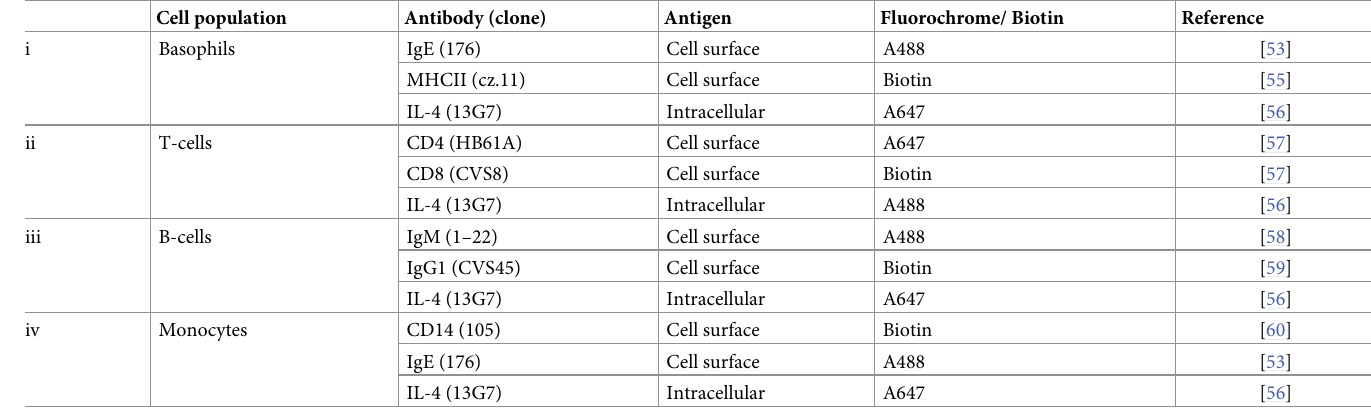
Table 2. Equine monoclonal antibodies against cell surface antigens and intracellular IL-4 used for staining of PBMC and flow cytometric analysis. Cell